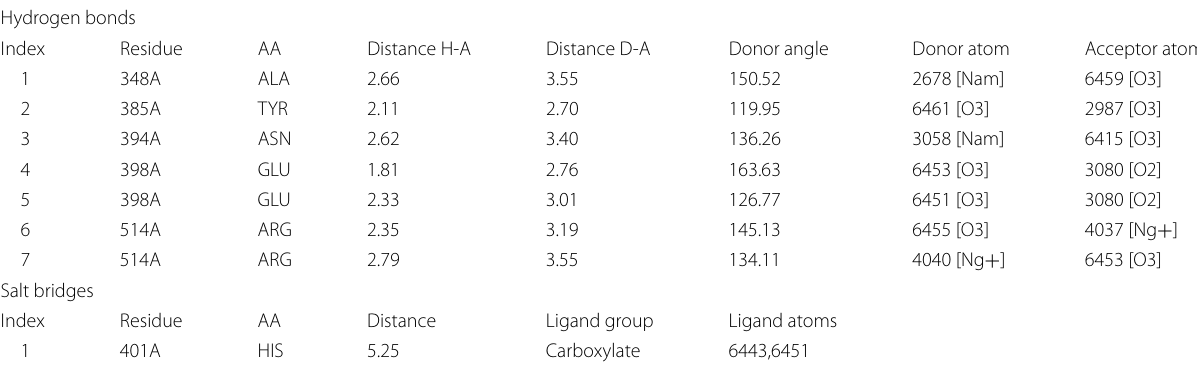
Table 4 Interactions of quercetin 3-[rhamnosyl-(1- > 2)-alpha-L-arabinopyranoside] with spike protein receptor-binding domain Hydrogen bonds